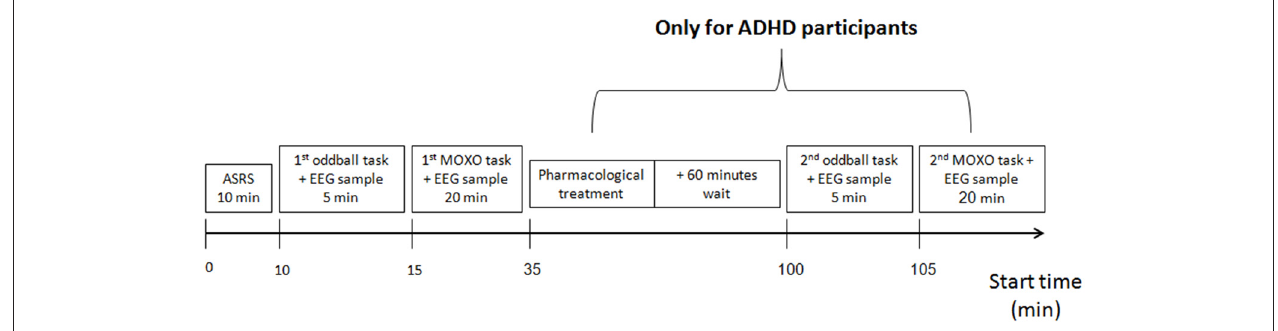
FIGURE 1 | Experiment procedure. All participants underwent ADHD self-report scale (ASRS) evaluation, then electrophysiological measurement, using the auditory oddball and the MOXO continuous performance test (CPT). Next, attention deficit hyperactivity disorder (ADHD) participants received pharmacological treatment, and after a 60-min wait were re-measured, using a second auditory oddball and a second MOXO CPT.